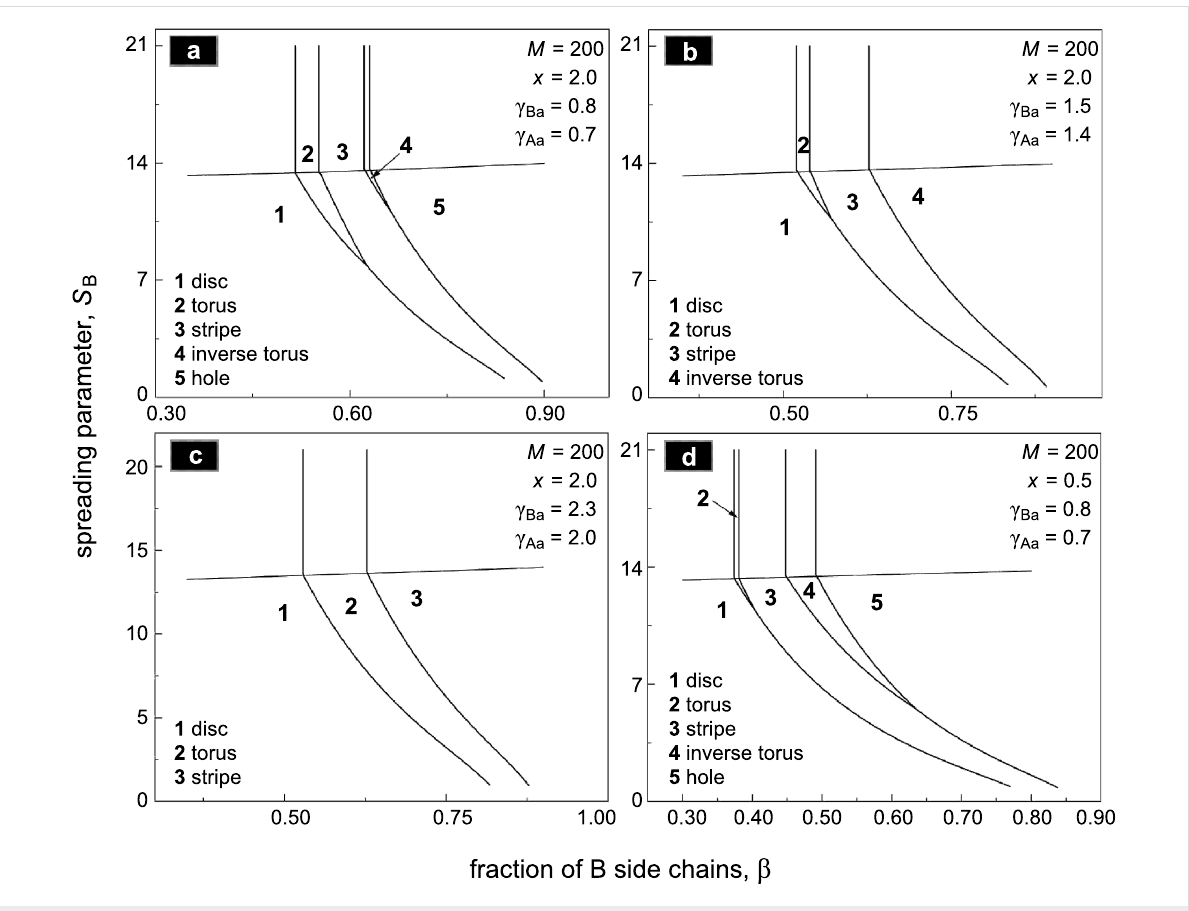
Figure 10: Phase diagram of the film in terms of the fraction of B side chains, β = N B /( N A + N B ), and the spreading parameter S B . The line splits the regions of flat and prominent morphologies. The spreading parameter S A satisfies the inequality to ensure 2D conformation of A